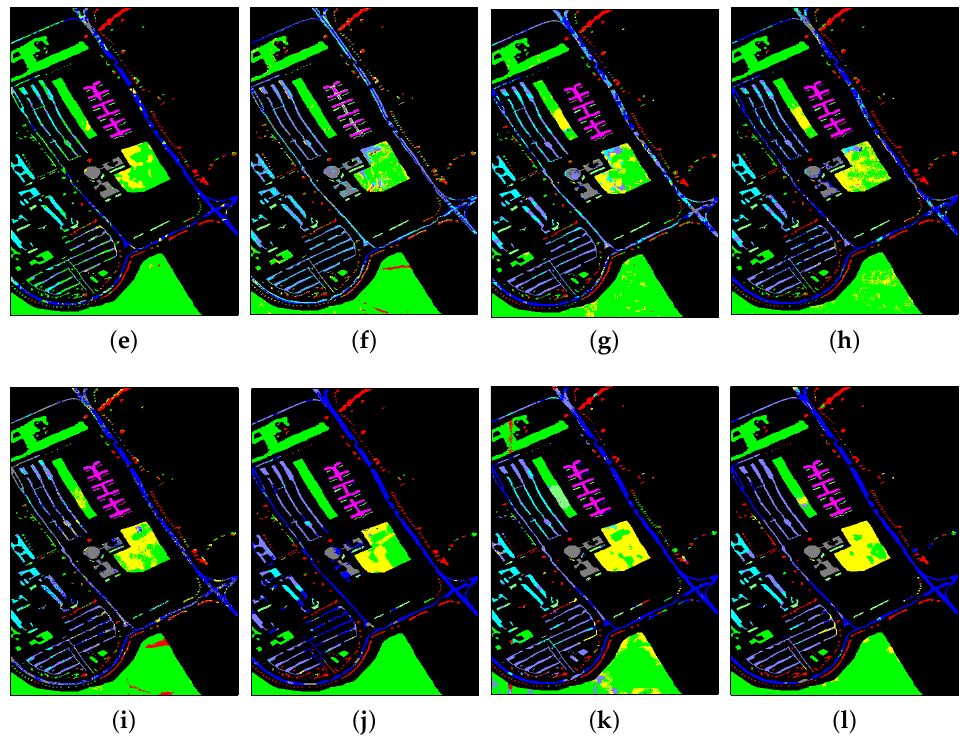
Figure 6. Classification maps on UP: Classification maps on IP: ( a ) Groundtruth, ( b ) SVMCK, ( c ) LCMR, ( d ) LCEM, ( e ) A2S2K, ( f ) NoiseCNN, ( g ) JSR, ( h ) KJSR, ( i ) SPKJSR, ( j ) CovKJSR, ( k ) CEKJSR, ( l ) LMFKJSR.